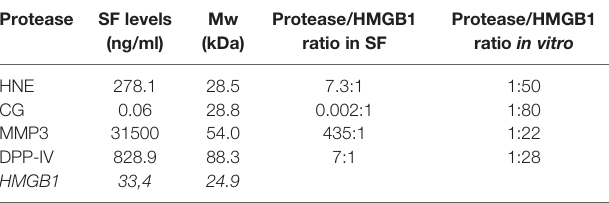
TABLE 2 | Molar ratios of proteases and HMGB1.